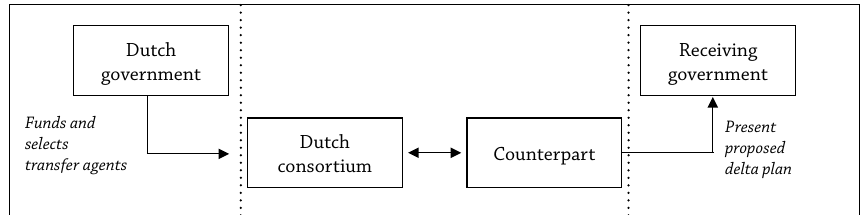
Figure 1. Simplified, schematic overview of the actors involved in the transfer process. The actors in the middle, between the two dotted lines, are those directly involved in translating the DDA to the receiving